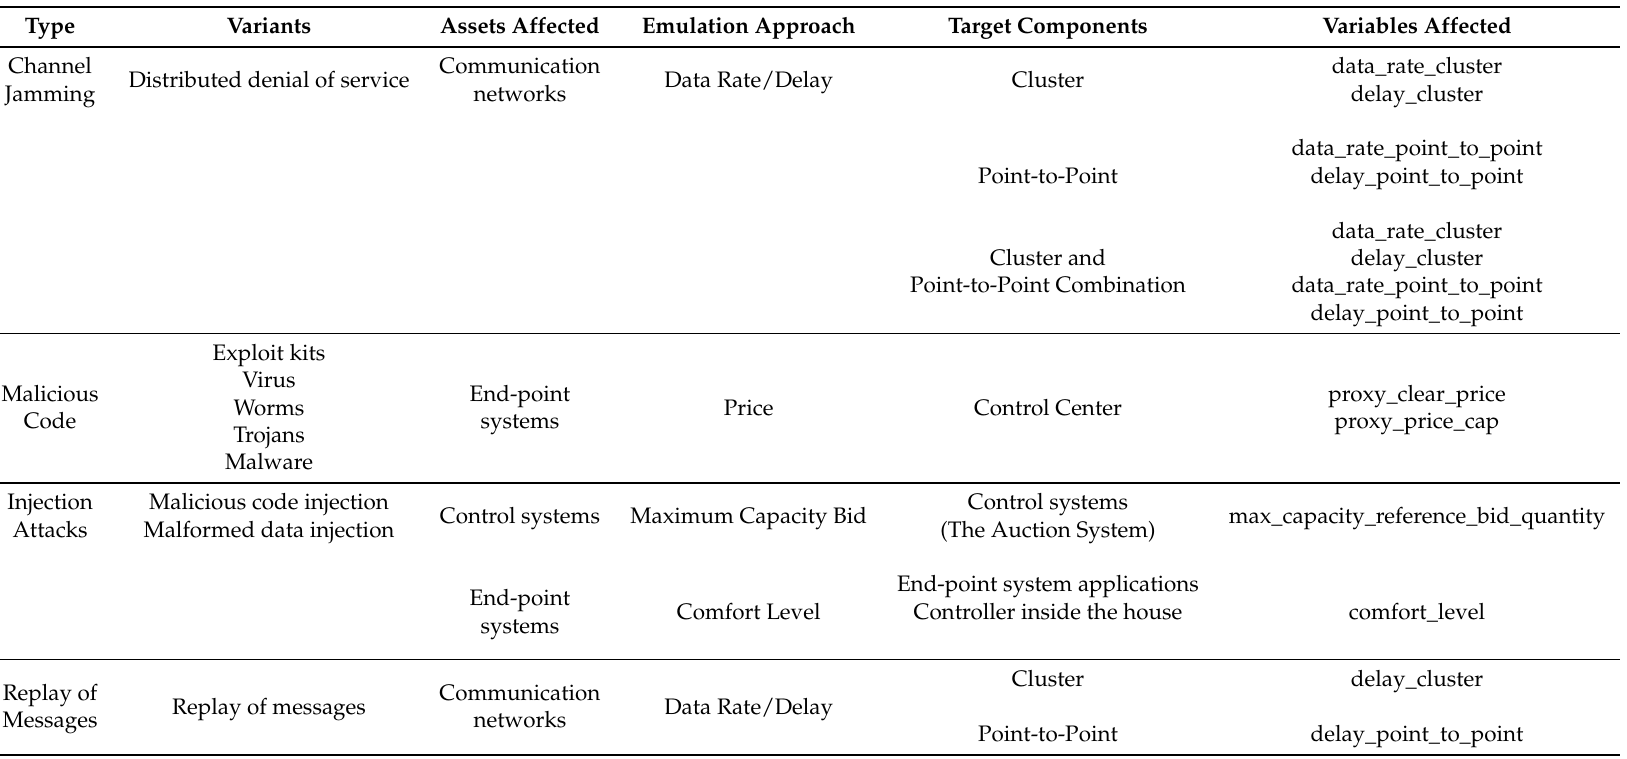
Table 3. The configuration of the attack pattern